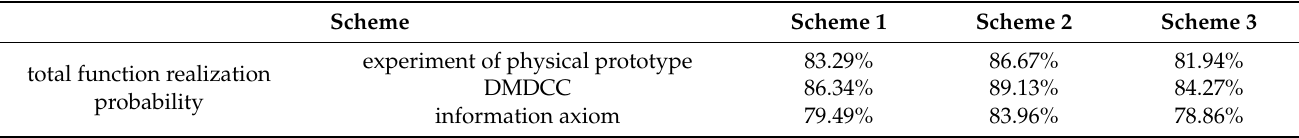
Table A5. Comparison of Function Realization Probability of Three Physical